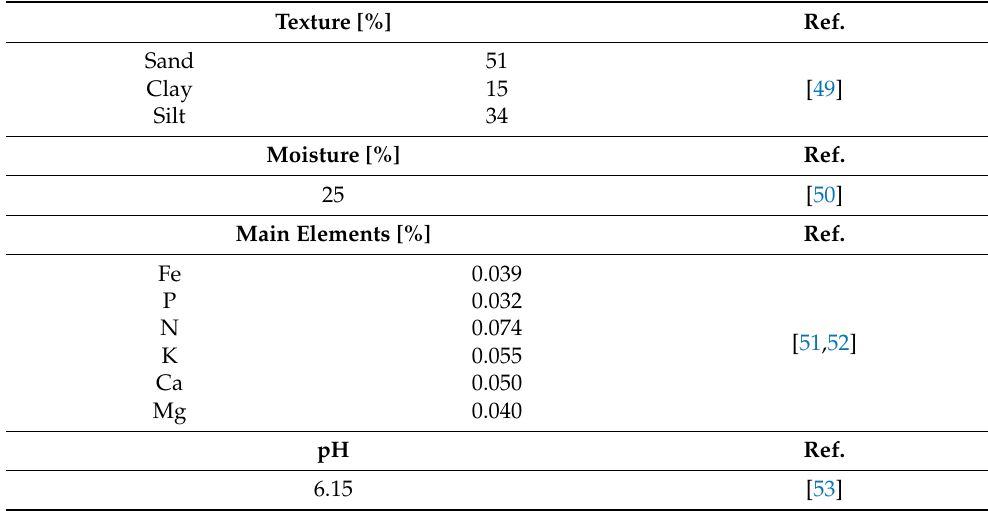
Table 3. Physical and chemical properties of the soil used in the